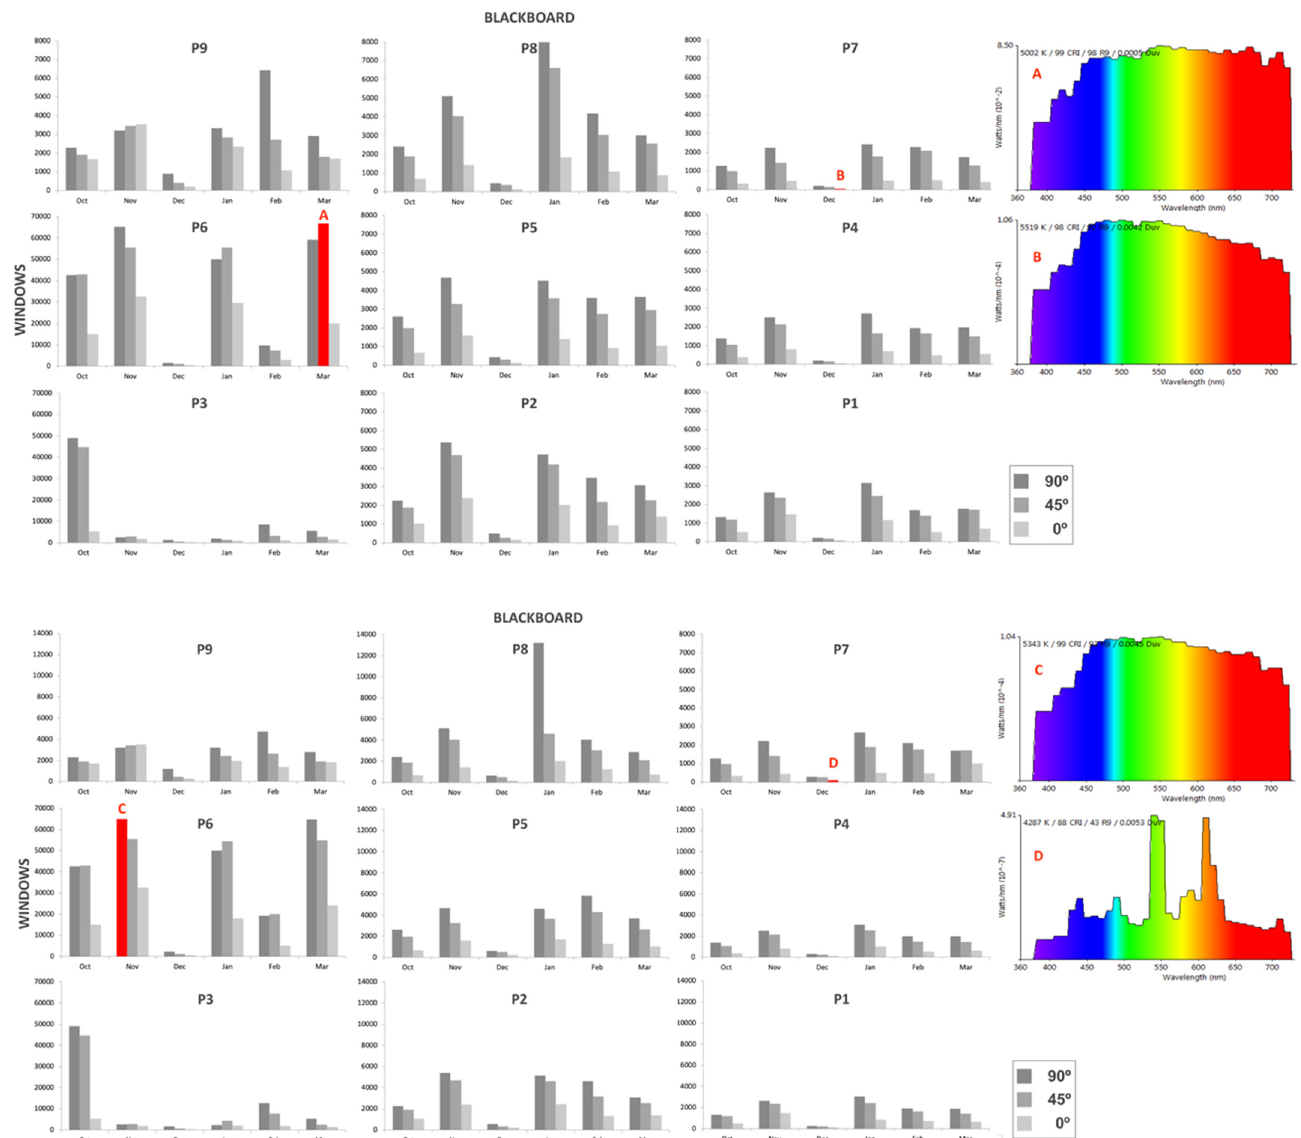
Figure 4. Classroom 1. Melanopic values according to the CIE standard (EDI melanopic lux) acting, in upper figure daylighting in Classroom 1 at each point (P1, P2, P3, P4, P5, P6, P7, P8 and P9) and in the three gaze orientations (0°, 45° and 90°); in lower figure, daylighting + artificial lighting in Classroom 1 at each point (P1, P2, P3, P4, P5, P6, P7, P8 and P9) and in the three gaze orientations (0°, 45° and 90°). Right figures, SPD of ( A ) maximum daylighting in the month of March at Point 6 with 45° orientation; ( B ) minimum daylighting in December at Point 7 with orientation at 0°; ( C ) maximum daylighting + artificial lighting in the month of November at Point 6 with 90° orientation; ( D ) minimum daylighting + artificial lighting in the month of December at Point 7 with orientation at 0°. OsramColorCalculator was used to plot the SPDs.